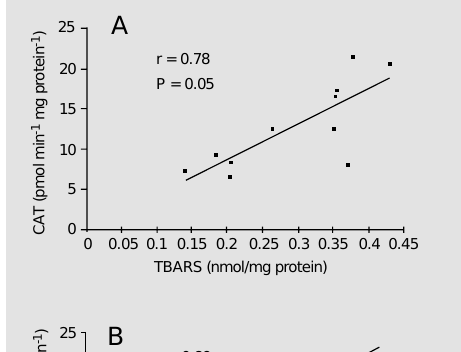
Figure 1 - Positive correlation obtained by linear regression in latissimus dorsi (LD) muscle of control and diabetic groups be- tween: A , Thiobarbituric acid re- active substances (TBARS, nmol/ mg protein) and catalase activity (CAT, pmol min -1 mg protein -1 ); B , chemiluminescence (cps/mg protein) and CAT activity (pmol min -1 mg protein -1 ), and C , CAT activity (pmol min -1 mg protein -1 ) and glutathione peroxidase ac- tivity (GPx, µmol min -1 mg pro- tein -1